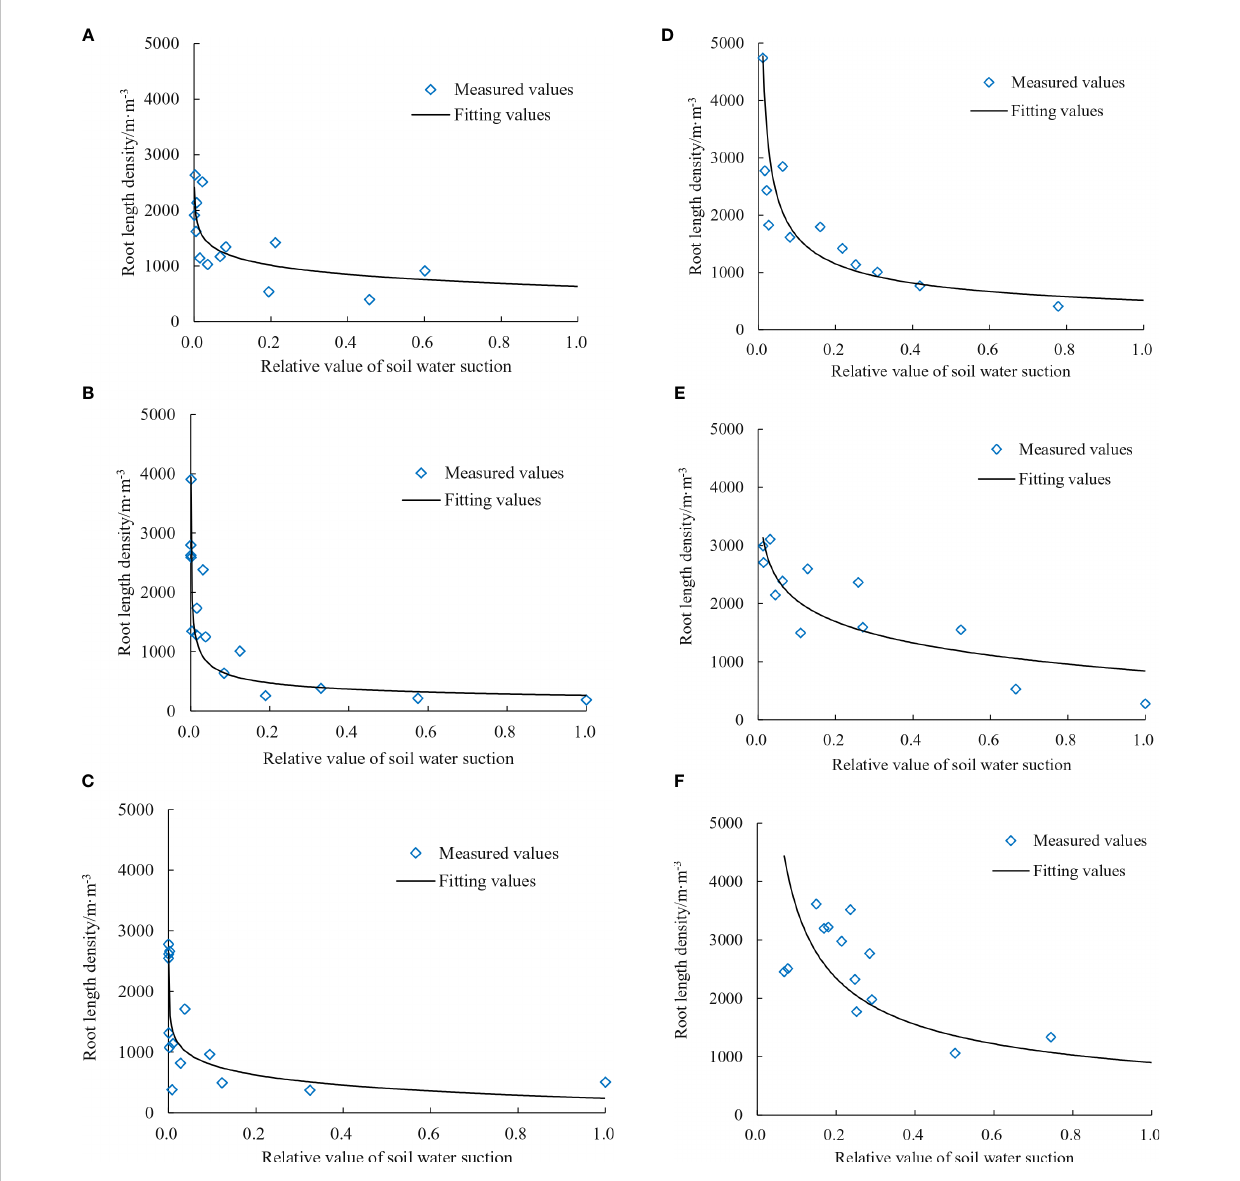
FIGURE 6 Relationship between root length density of the cotton group and soil water suction. (A) Bud stage of 30-cm planting spacing. (B) Bud stage of 15- cm planting spacing. (C) Flowering stage of 30-cm planting spacing. (D) Flowering stage of 15-cm planting spacing. (E) Boll stage of 30-cm planting spacing. (F) Boll stage of 15-cm planting